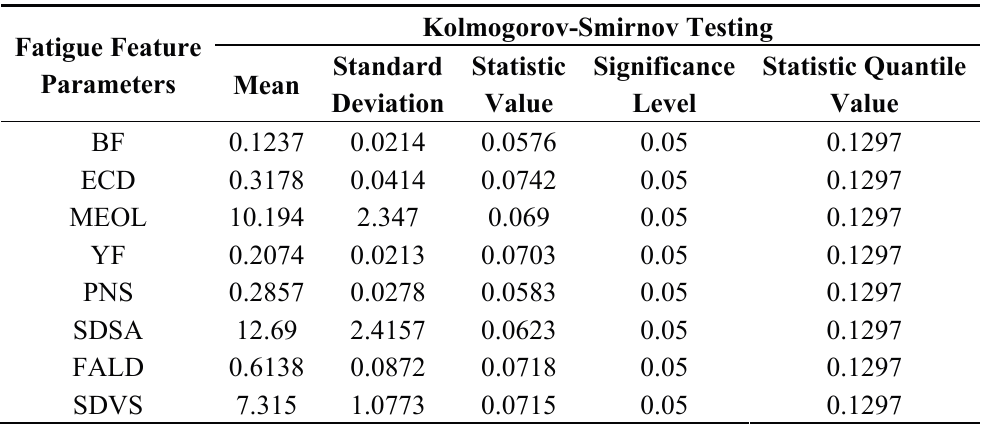
Table 3. Normal distribution testing of fatigue